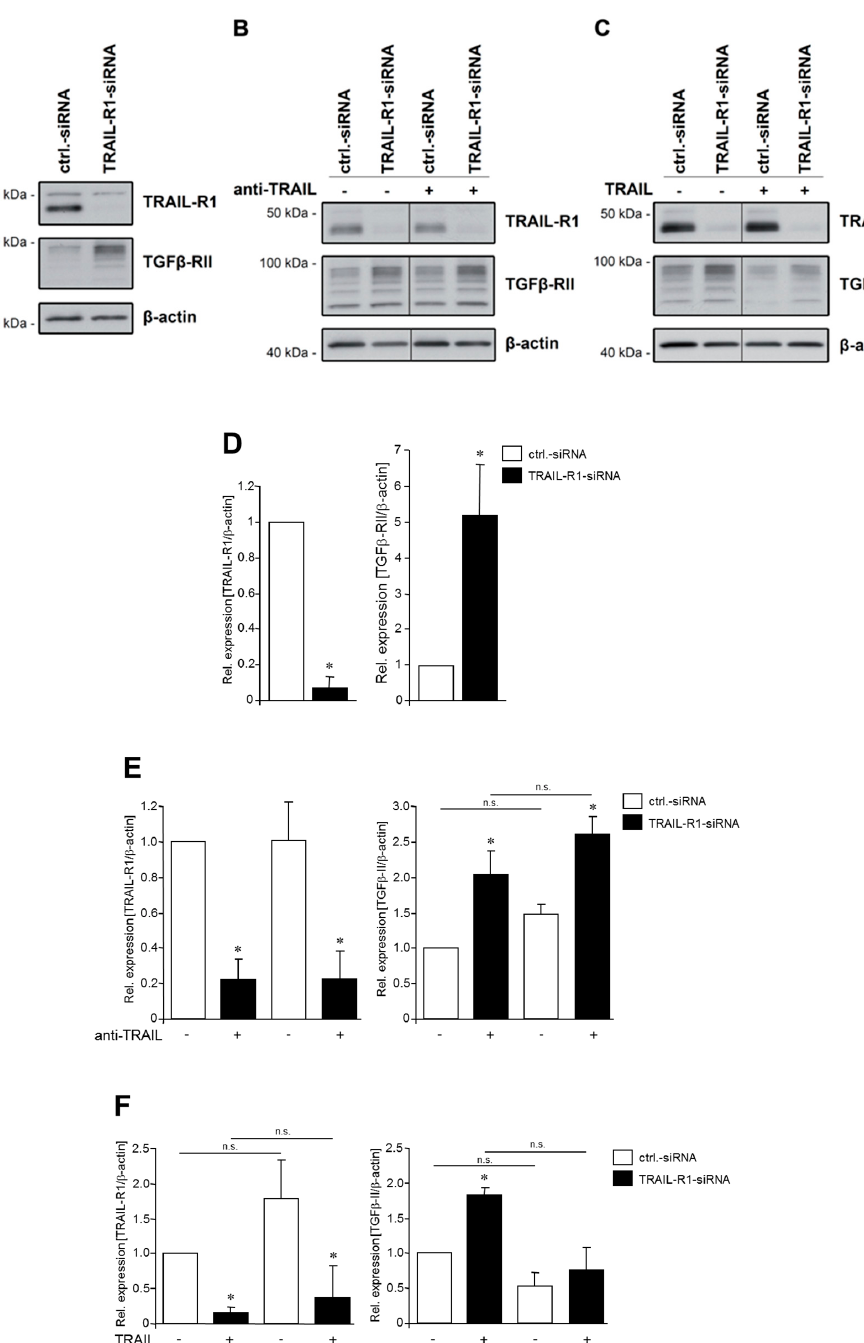
Figure 3. Knockdown of TRAIL-R1 increases the abundance of TGF β -RII in Panc1 cells. Panc1 cells were transfected with siRNA against TRAIL-R1 or with control siRNA for 72 h without ( A ) or with ( B ) exposure to a neutralizing antibody against TRAIL (anti-TRAIL, 10 µg/mL) or ( C ) recombinant TRAIL (10 ng/mL). The expression of TRAIL-R1 and TGF β -RII was analysed by Western blotting in whole cell lysates. As control for equal gel loading, levels of β -actin were determined in parallel. The blots shown are representative of three independent experiments yielding very similar results. ( D ) Densitometry-based quantification of the Western blots shown in ( A ). Data were compiled from three independent experiments and represent the mean ± SD ( n = 3). ( E ) Densitometry-based quantification of the Western blots shown in ( B ). ( F ) Densitometry-based quantification of the Western blots shown in ( C ). The asterisks ( * ) in ( D – F ) indicate significance relative to the ctrl.-siRNA; n.s.: not